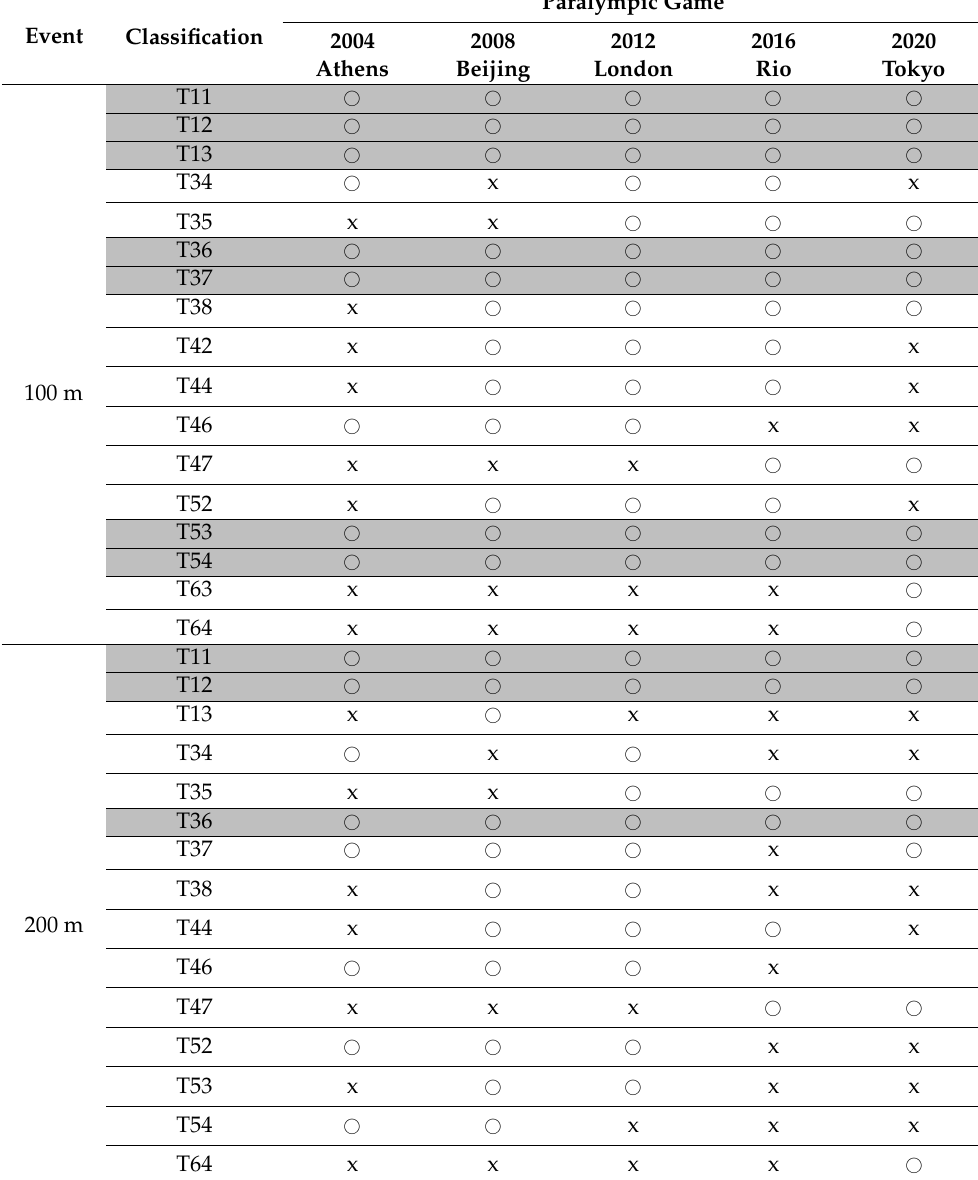
Table 2. Changes in Women’s Division Track Disciplines in the Paralympic Games.